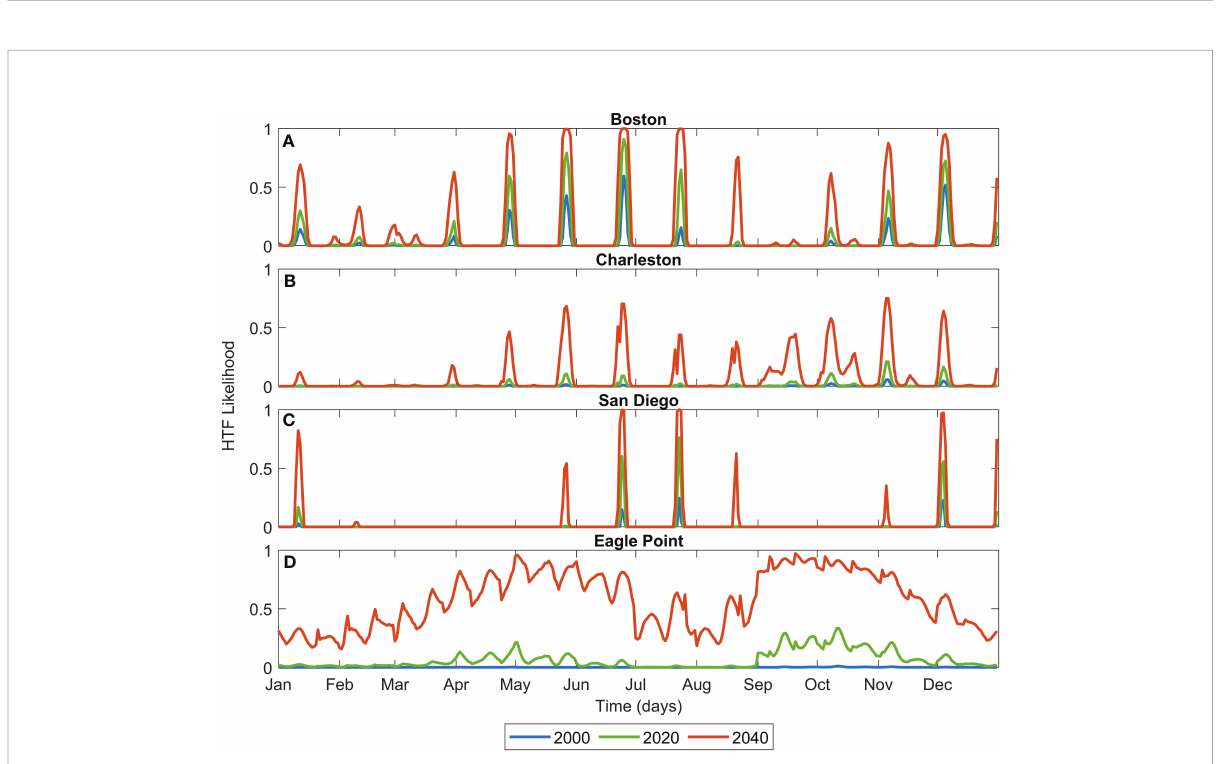
FIGURE 10 Examples of HTF prediction at Boston, MA (A) , Charleston, SC (B) , San Diego, CA (C) and Eagle Point, TX (D) for one year assuming MSL at levels observed in 2000 (blue), 2020 (green) and projected with the Intermediate Scenario for 2040